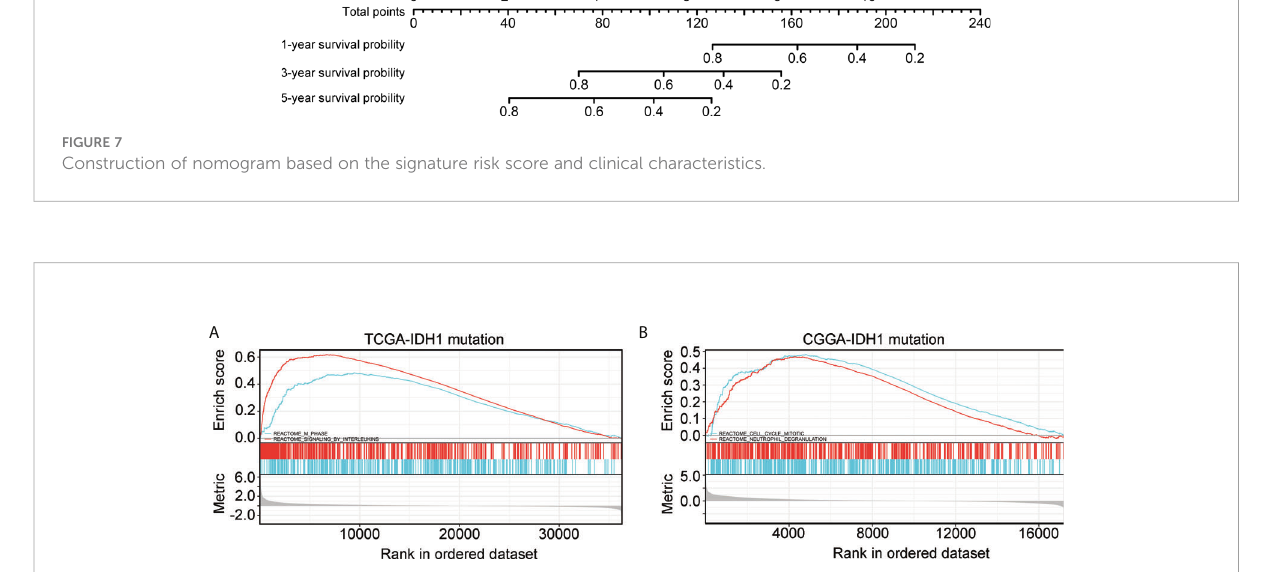
FIGURE 8 GSEA analysis of the pathway terms enriched in high-risk score IDH1mt-glioma tissues in TCGA (A) and CGGA (B) .